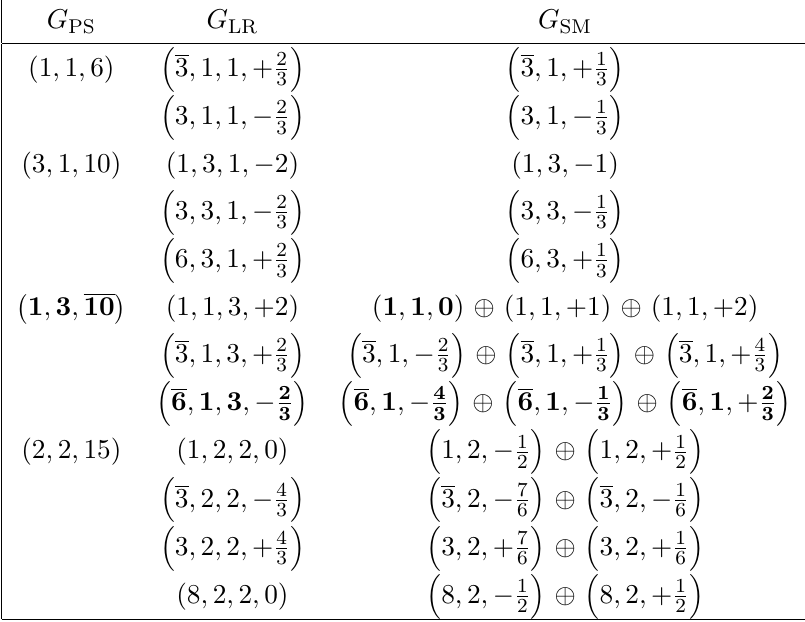
the intermediate symmetry corresponds to a left-right symmetric gauge group G broken D -parity